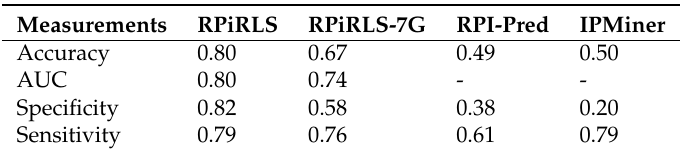
Table 5. Comparision of RPiRLS with other methods on the RPI2241 data set in predicting RNA-protein interactions with known